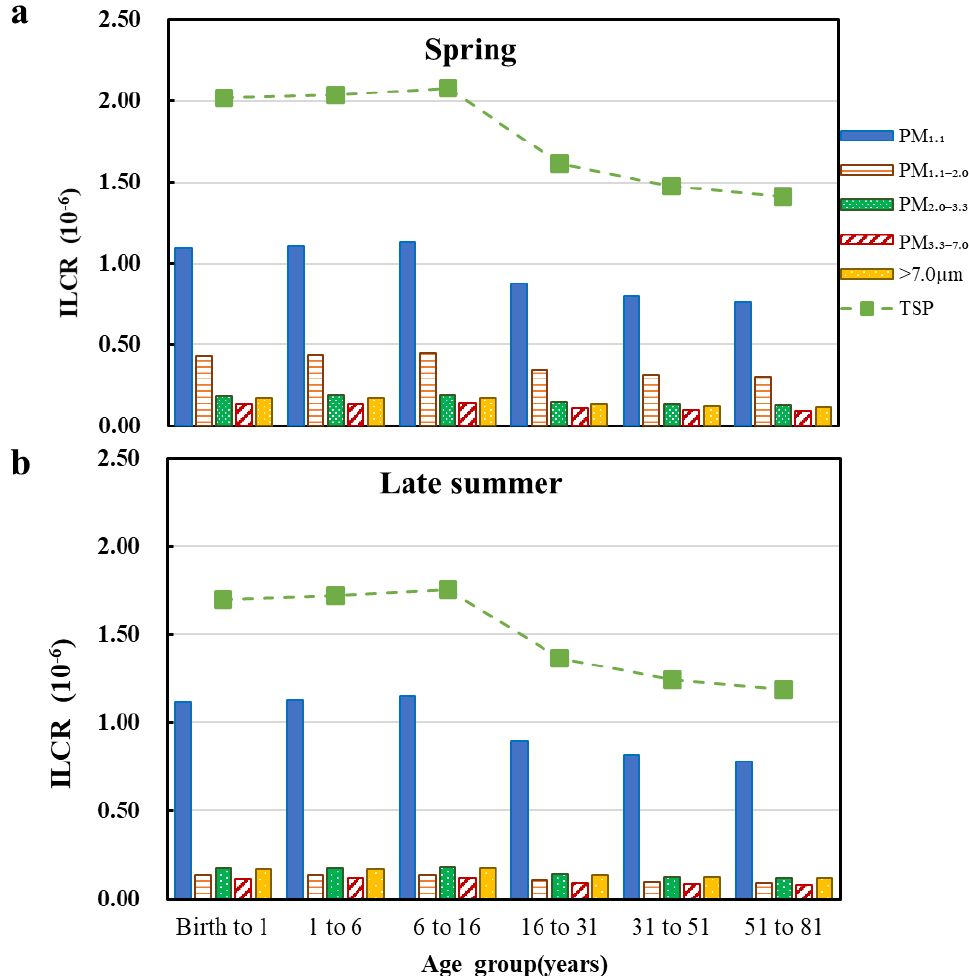
Figure 5. The ILCR values in five particles during the spring ( a ) and late summer ( b ) sampling